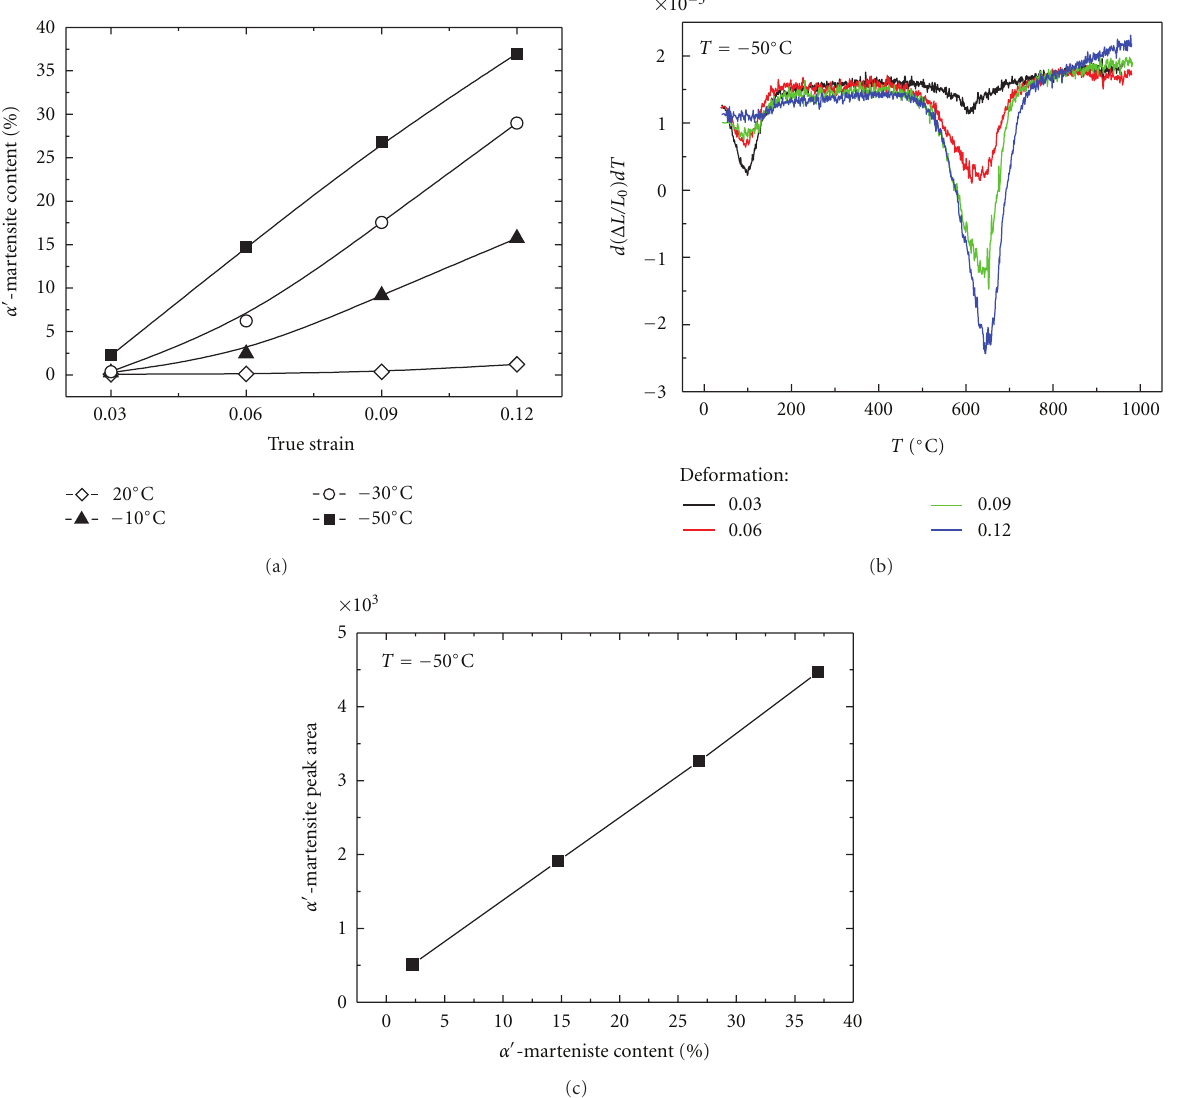
Figure 4: (a) α (cid:3) -martensite content as result of applied strain. (b) Dilatometric curves of samples tensile deformed of 0.03, 0.06, 0.09, and 0.12 with previous deformation at − 50 ◦ C. (c) Linear relation between α (cid:3) -martensite peak area and content measured by ferritoscope in deformed specimen with previous deformation at − 50 ◦